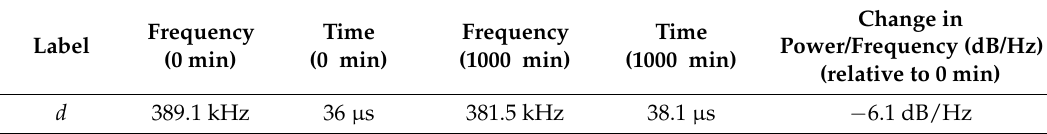
Table 4. Triangular specimen (Near): Wave